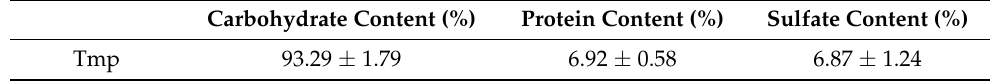
Table 1. Chemical composition of Tmp.